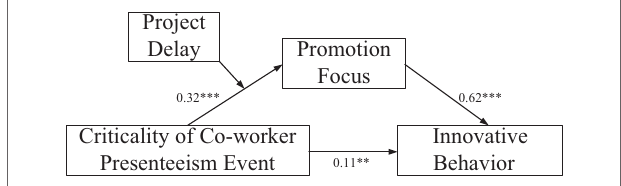
FIGURE 2 | Results of research model by using model 7 of the PROCESS. ** p < 0.01; *** p < 0.001.